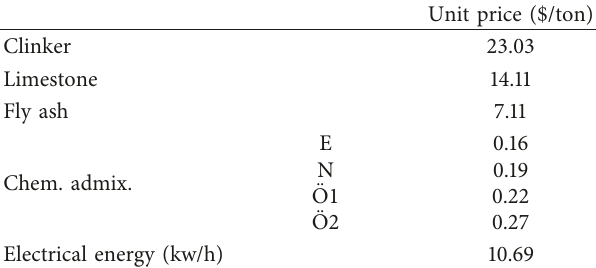
Table 5: Unit prices of the material used in cement production (in Turkey).